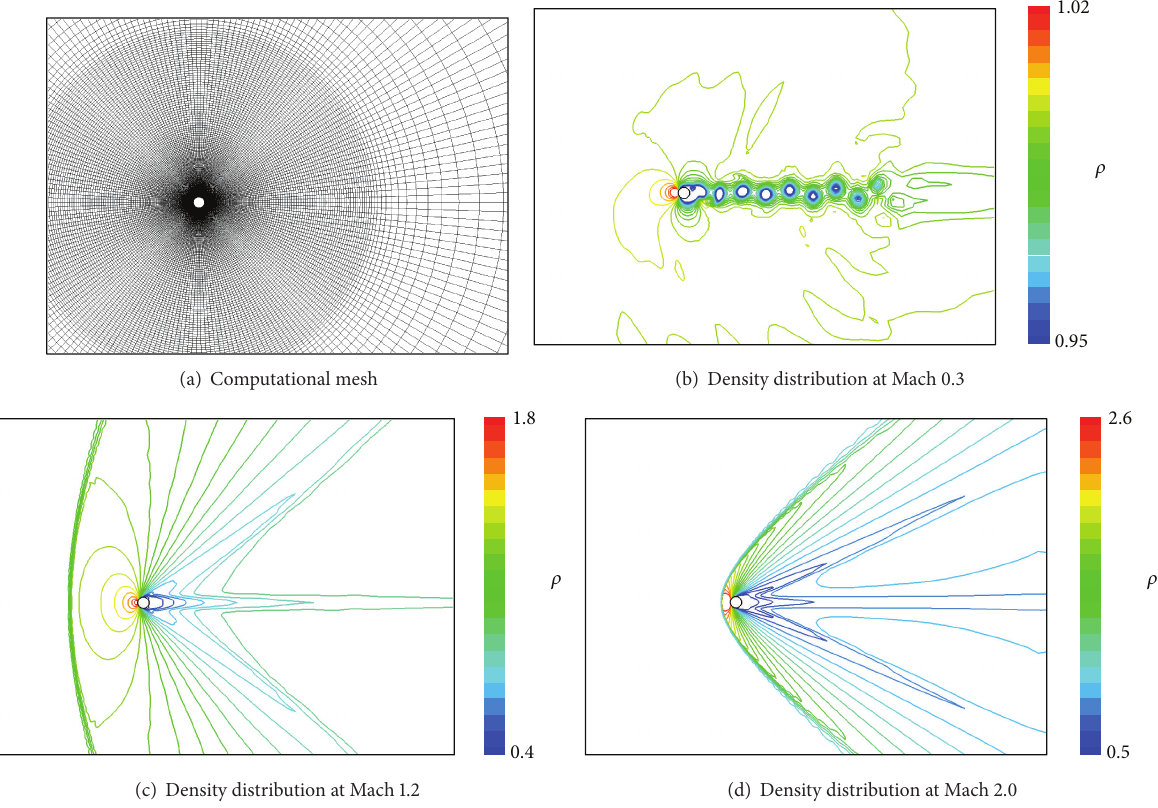
Figure 26: Density distribution computed by body-fitted coordinate code [24], simulating flow around a two-dimensional cylinder.